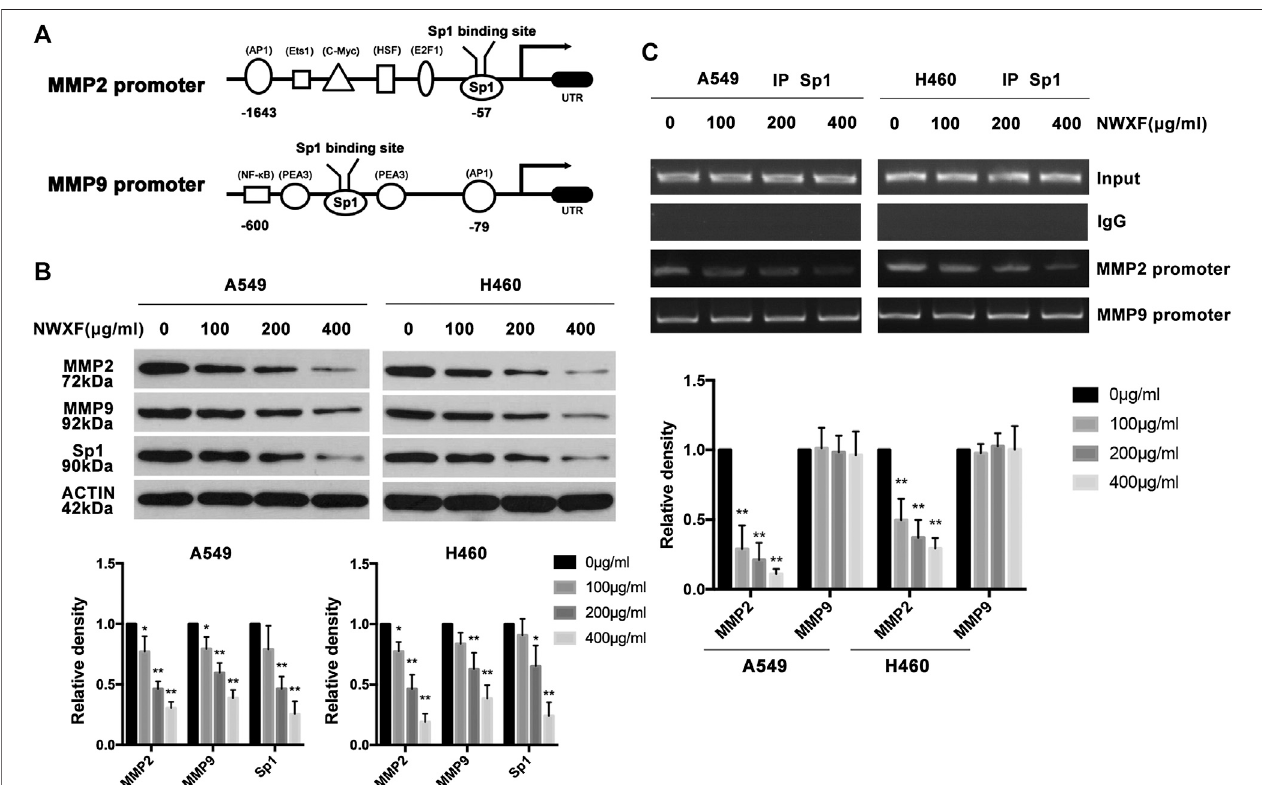
FIGURE2| NWXFinhibits expressionofSp1, MMP2,and MMP9inNSCLCcells. (A) Schematicrepresentation oftheputative Sp1bindingsite onthepromoterof MMP2 and MMP9. (B) A549 and H460 cells were treated with indicated concentrations of NWXF for 24 h, and then protein levels of Sp1, MMP2, and MMP9 were determined by immunoblotting. The relative protein levels were analyzed by alphaease FC software. (C) Chromatin immunoprecipitation (ChIP) analysis of the Sp1 binding to the MMP2 and MMP9 promoter region treated with NWXF for 24 h in A549 and H460 cells respectively. Data were shown as mean ± SD of three independent experiments. p p < 0.05, pp p < 0.01 vs.